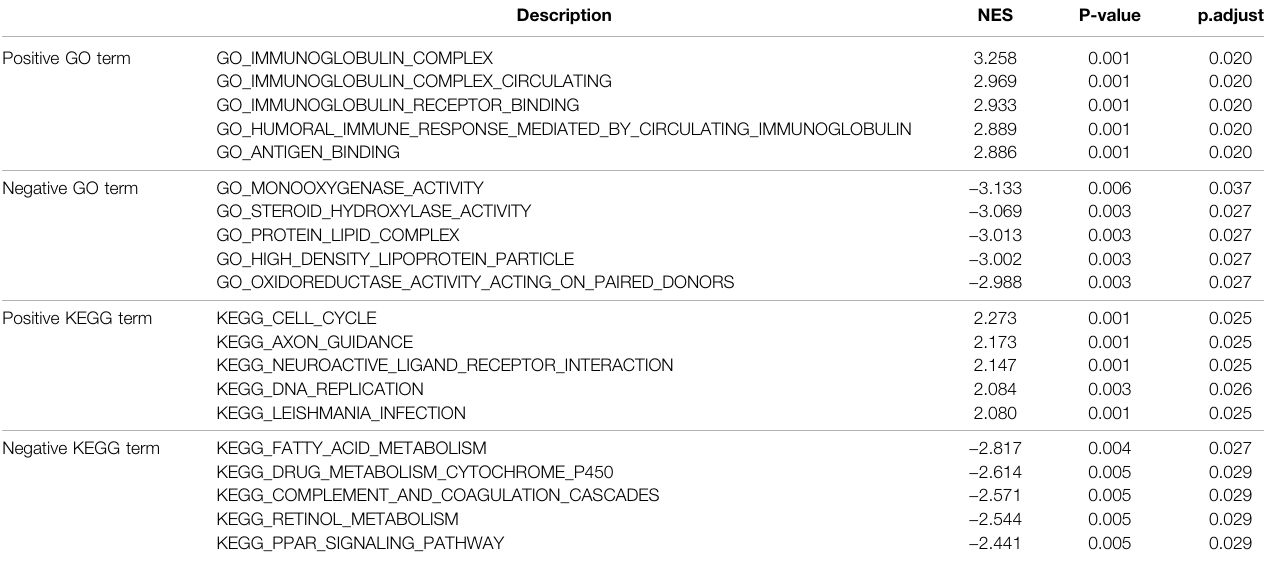
TABLE 2 | Signaling pathways most signi fi cantly associated with DDOST